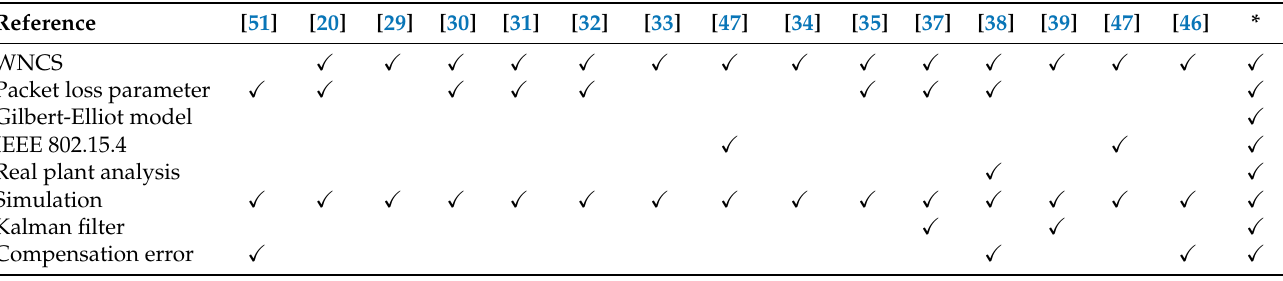
Table 1. Comparative